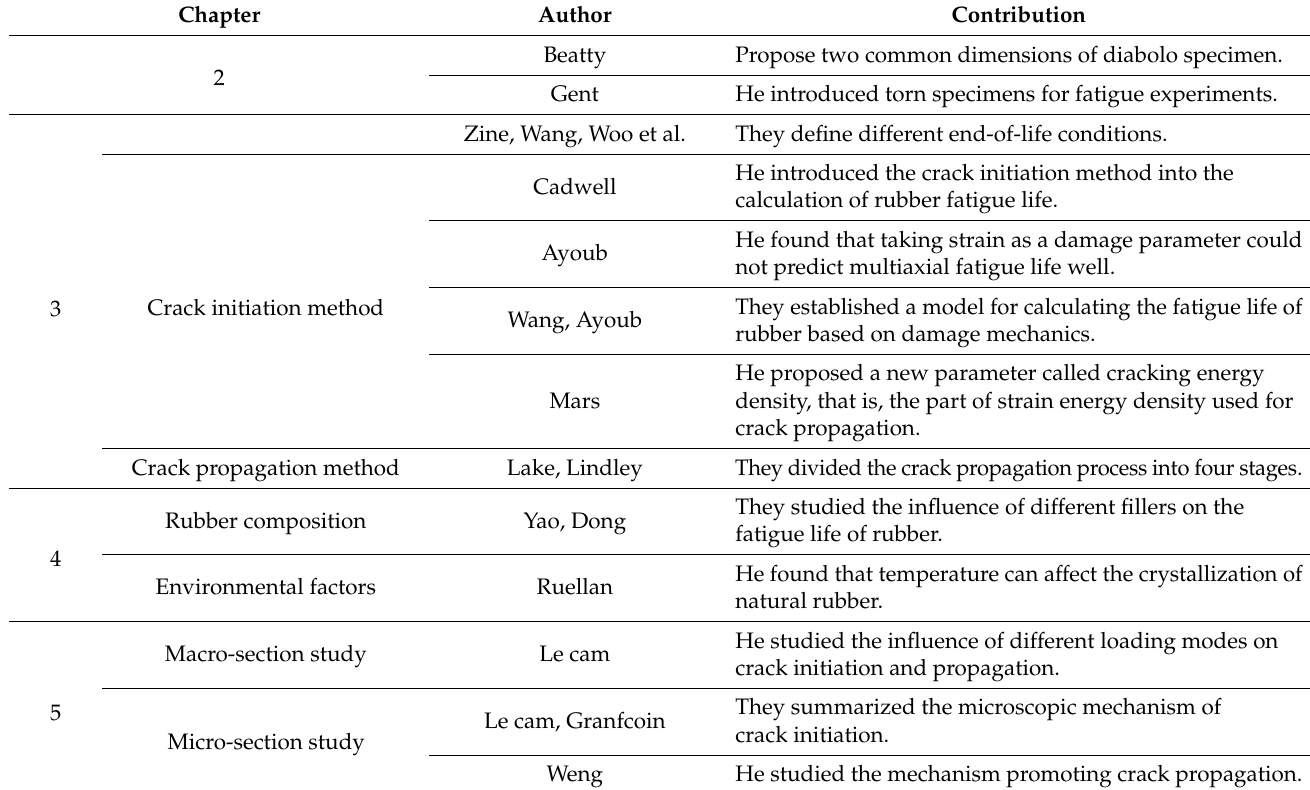
Figure 2. Number of literature articles in the last 20 years. Table 1. Some important references in the field of fatigue mentioned in this